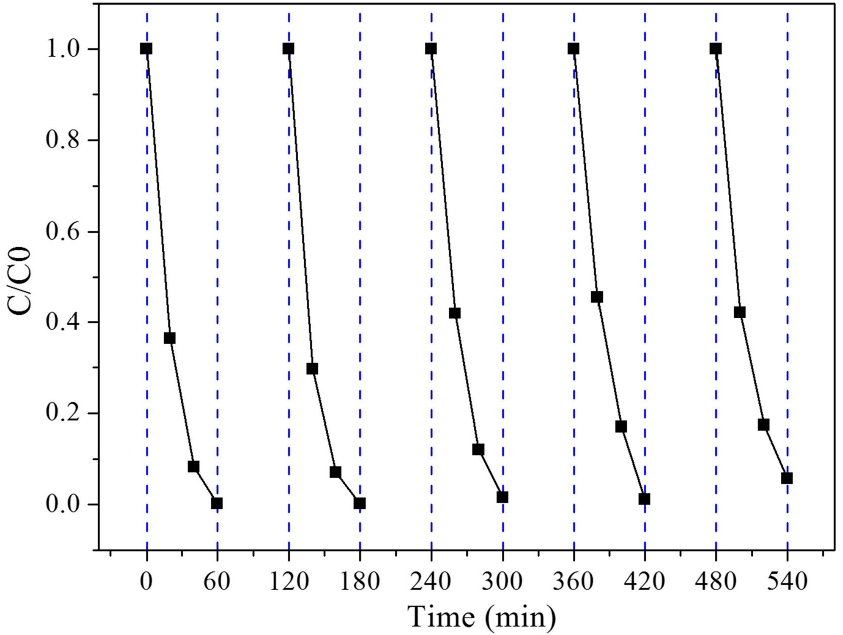
Figure 13. Cycle test of photocatalytic degradation of MO by TiO 2 @PMMA ([MO] = 10 mg/L). Reprinted with permission from [199].